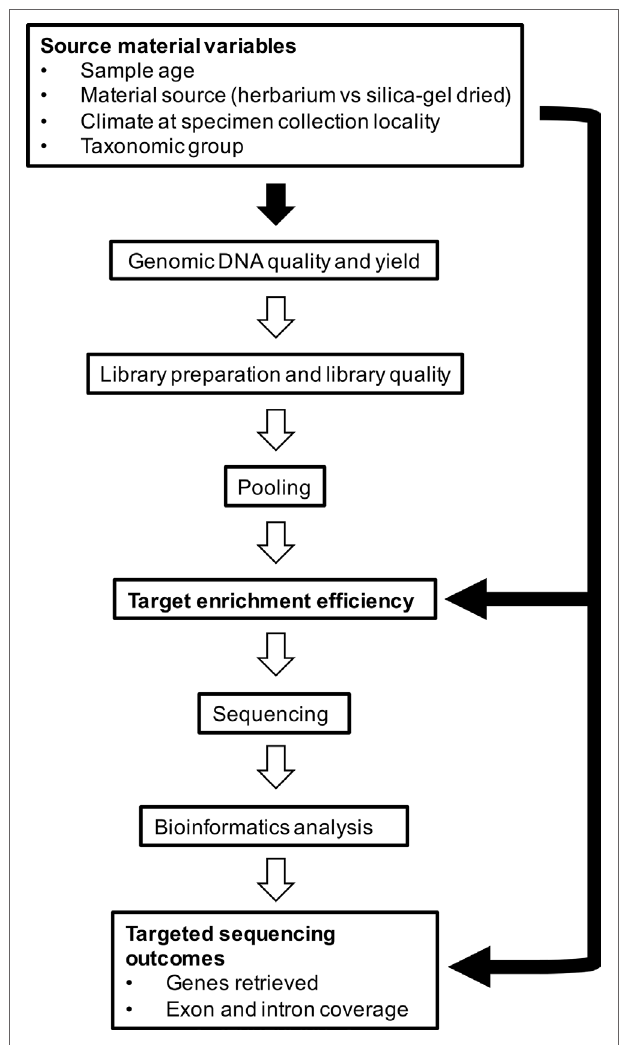
FIGURE 1 | Source material variables impact genomic DNA quality and yield, which feeds into library preparation and quality, pooling, target enrichment efficiency, sequencing, bioinformatics analysis, and targeted sequencing outcomes. In this study, we investigate the relationships shown by the black- filled